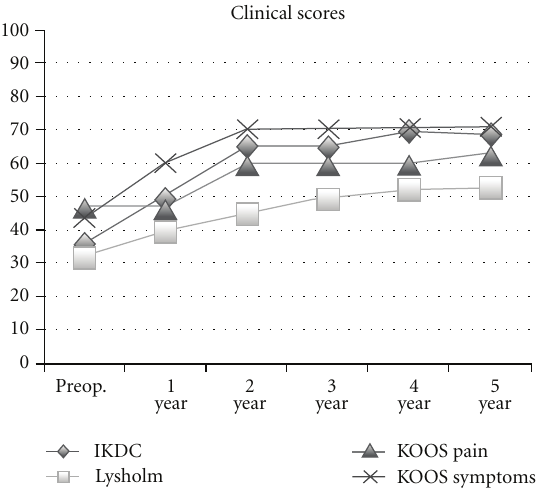
Figure 4: Preop. and yearly time follow-up for IKDC, Lysholm, KOOS pain and